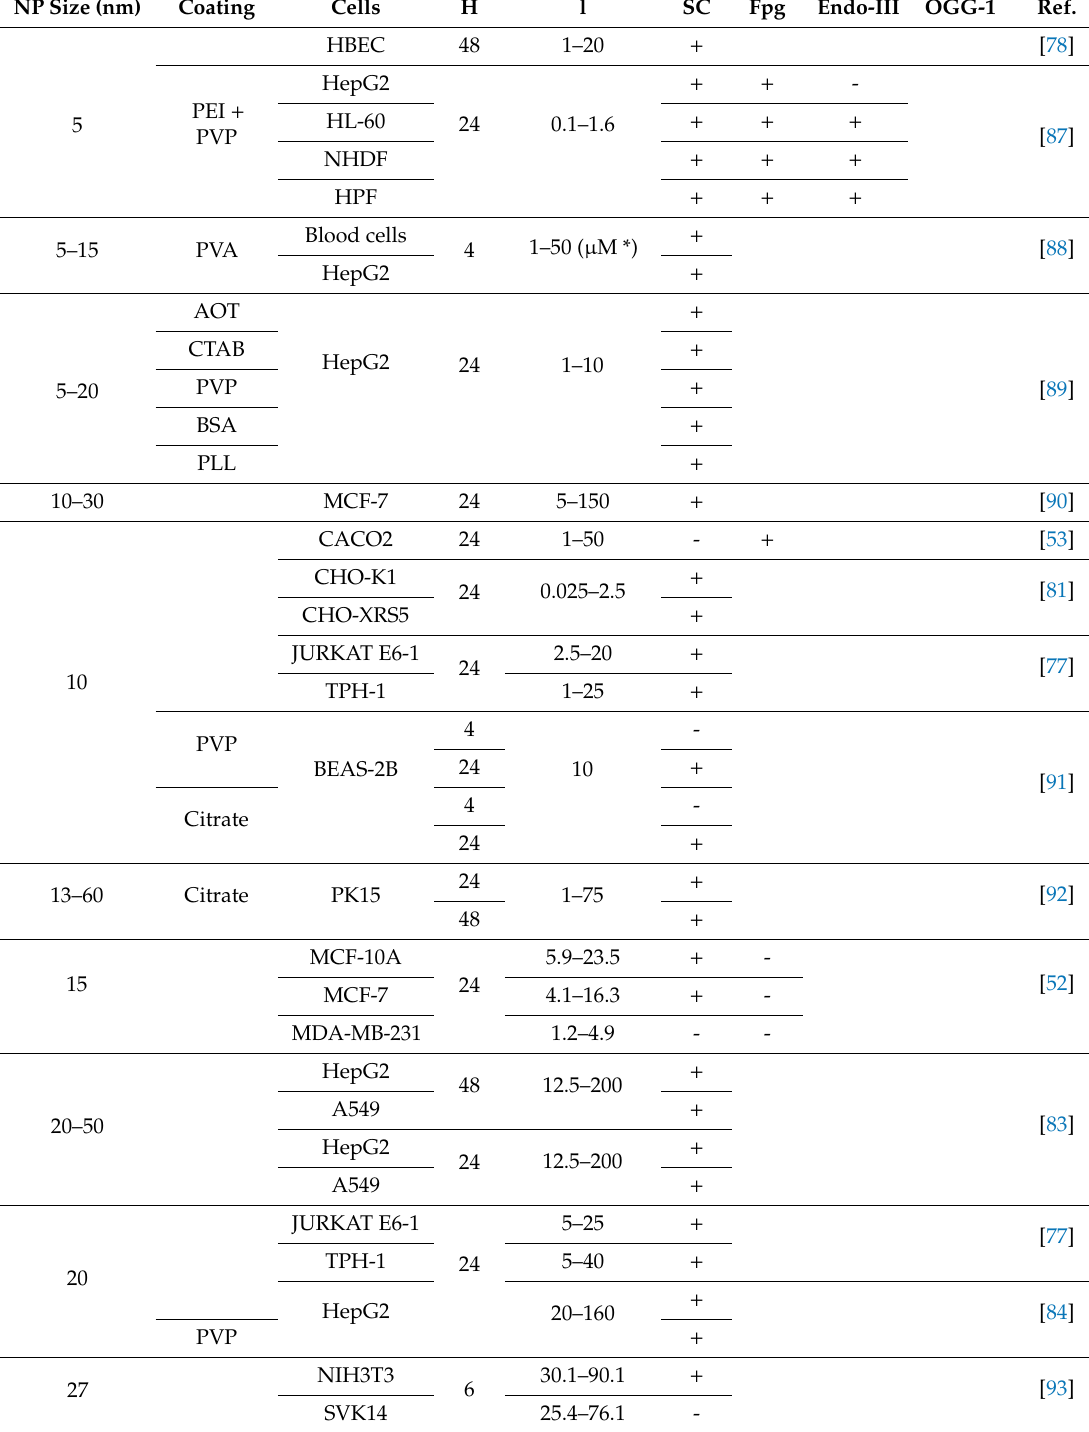
Table 3. In vitro comet assay